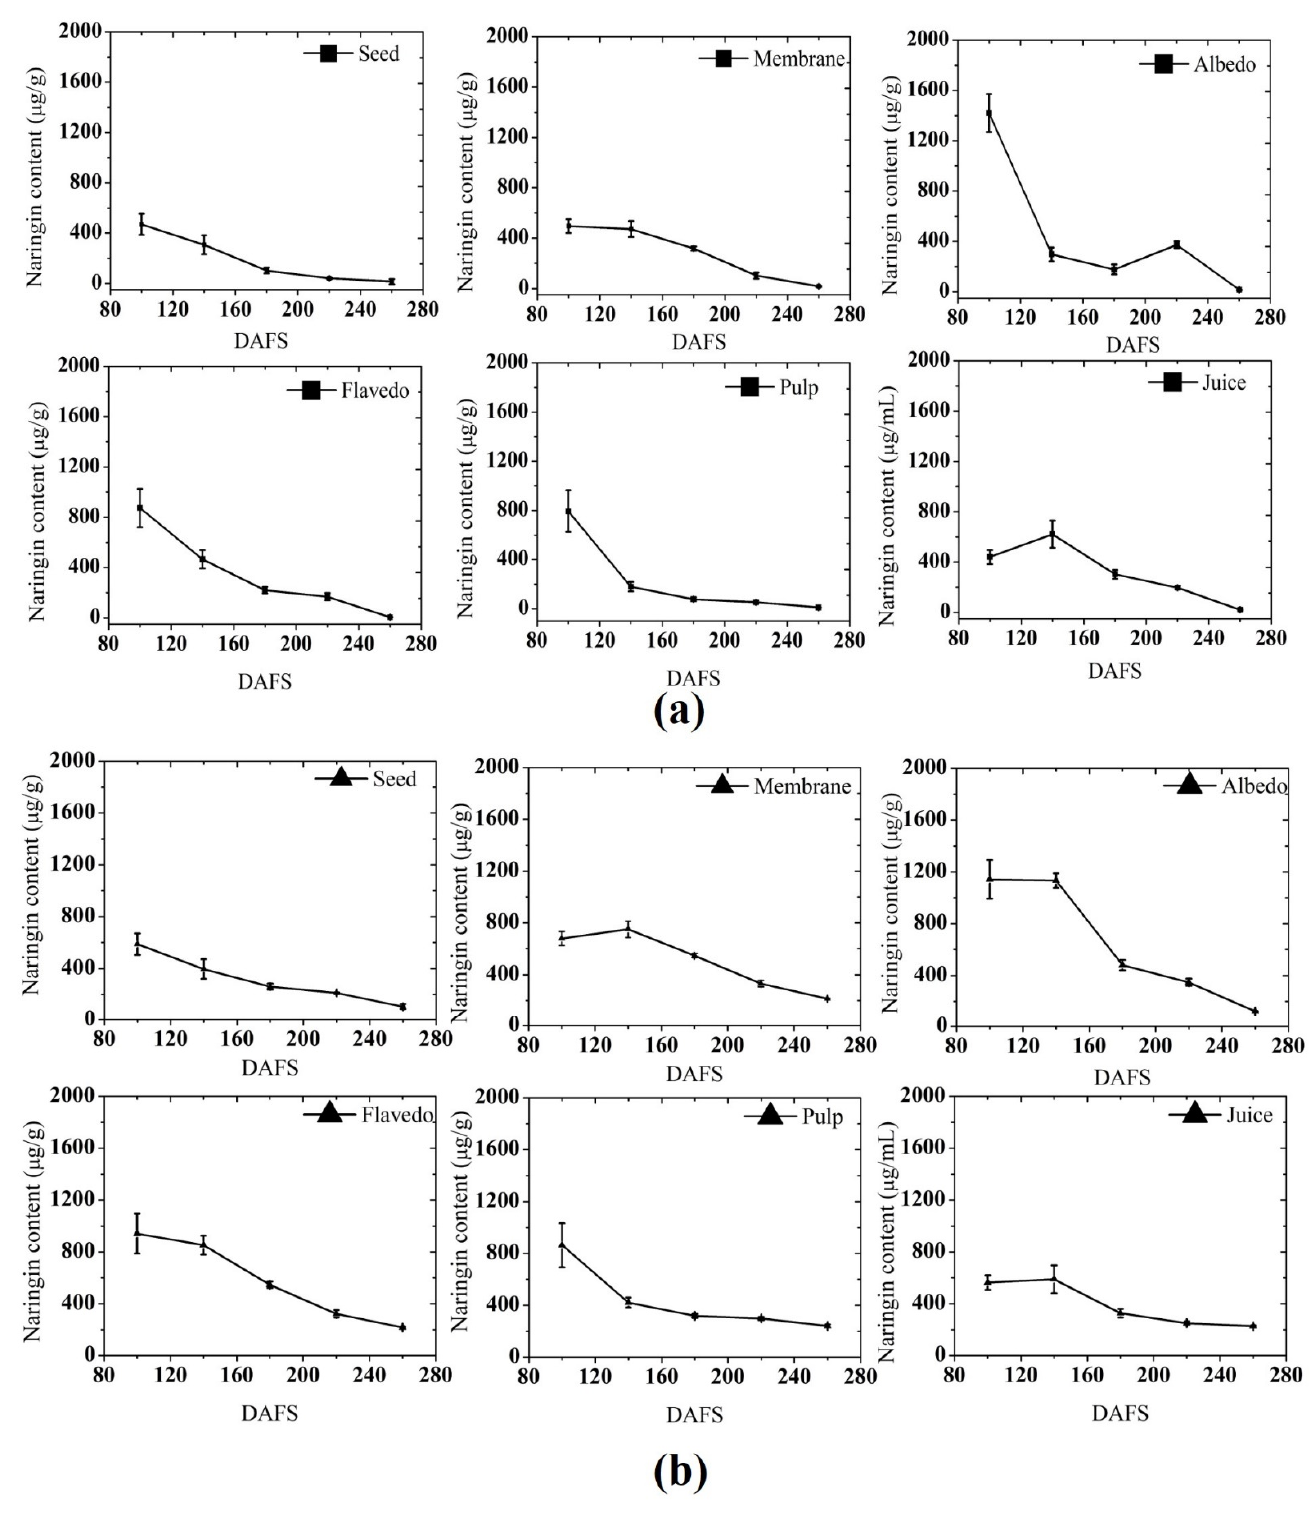
Figure 4. Naringin content estimated by HPLC in ( a ) 2018; and ( b ) 2019. DAFS; days after fruit set.